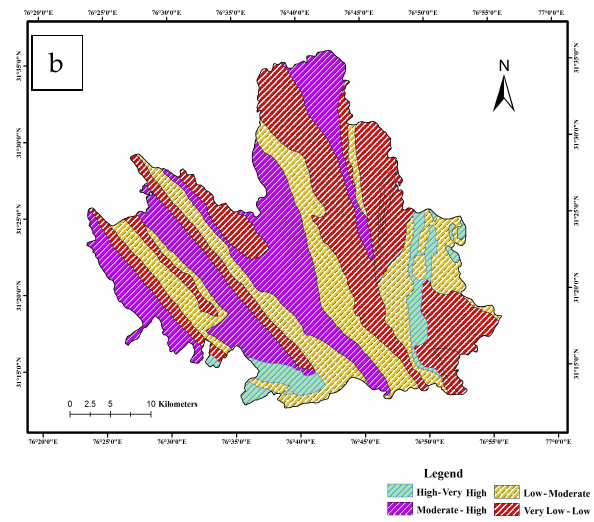
Figure 12. ( a ) Lithology map of Bilaspur district; ( b ) Lithology index map of Bilaspur district.